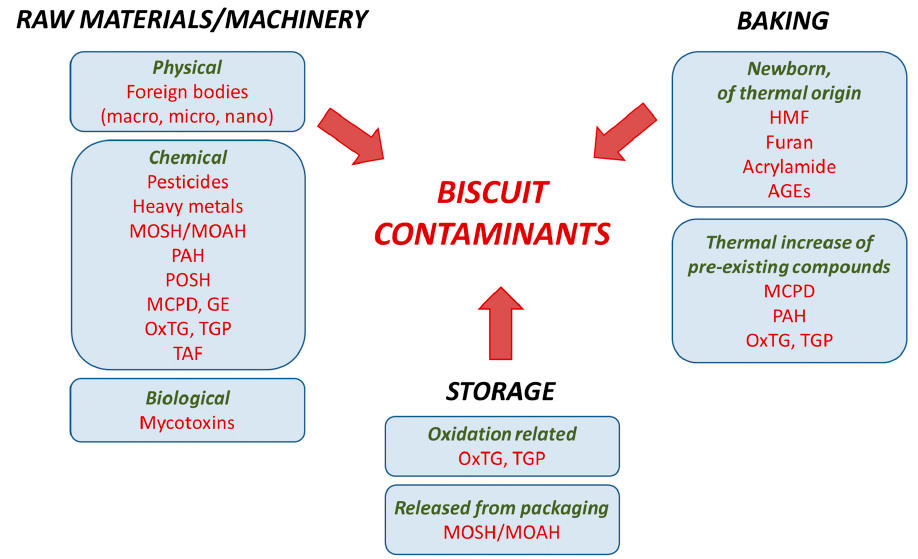
Figure 3. Possible biscuit contaminants from raw materials/machinery, baking process, and storage. MOSH = mineral oil saturated hydrocarbons; MOAH = mineral oil aromatic hydrocarbons; PAHs = polycyclic aromatic hydrocarbons; POSH = polyolefin oligomeric saturated hydrocarbon; MCPD = Monochloropropanediol esters; GE = glycidyl esters; OxTG = oxidized triglycerides; TGP = triglyceride oligopolymers; TFA = trans fatty acids; HMF = 5-hydroxymethyl furfural; AGEs = advanced glycation end-products.